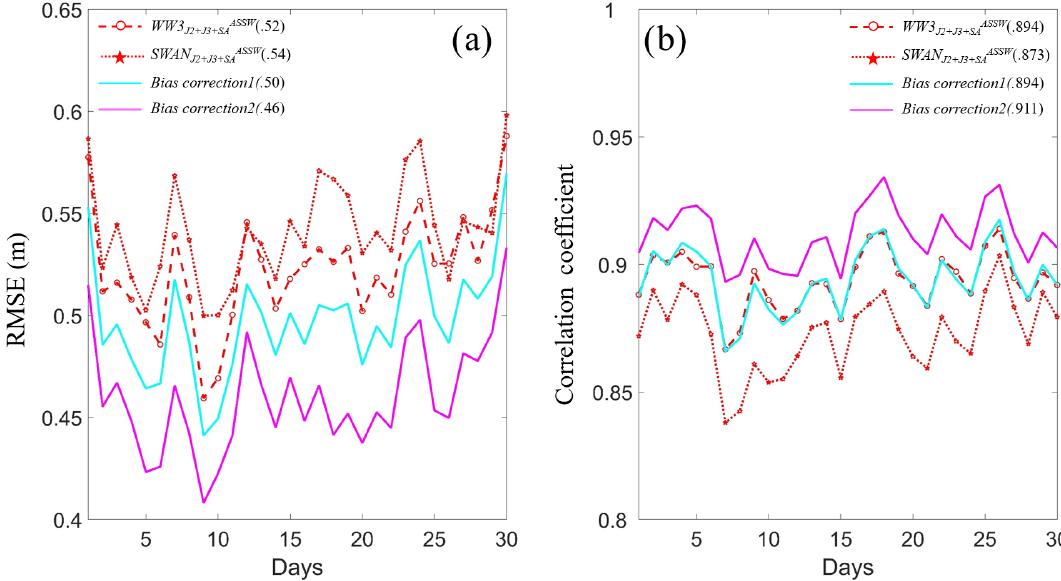
Figure 8. Time series of (a) RMSEs and (b) spatial correlation coefficients produced by two bias correction schemes (cyan and pink) through a combination of WW3 and SWAN assimilations with the data from three satellites (Jason-2, Jason-3 and SARAL) and wind correction starting from the ERA-Interim wind. The results of the individual assimilation systems are plotted as dotted and dashed red lines (taken from Fig. 7) for